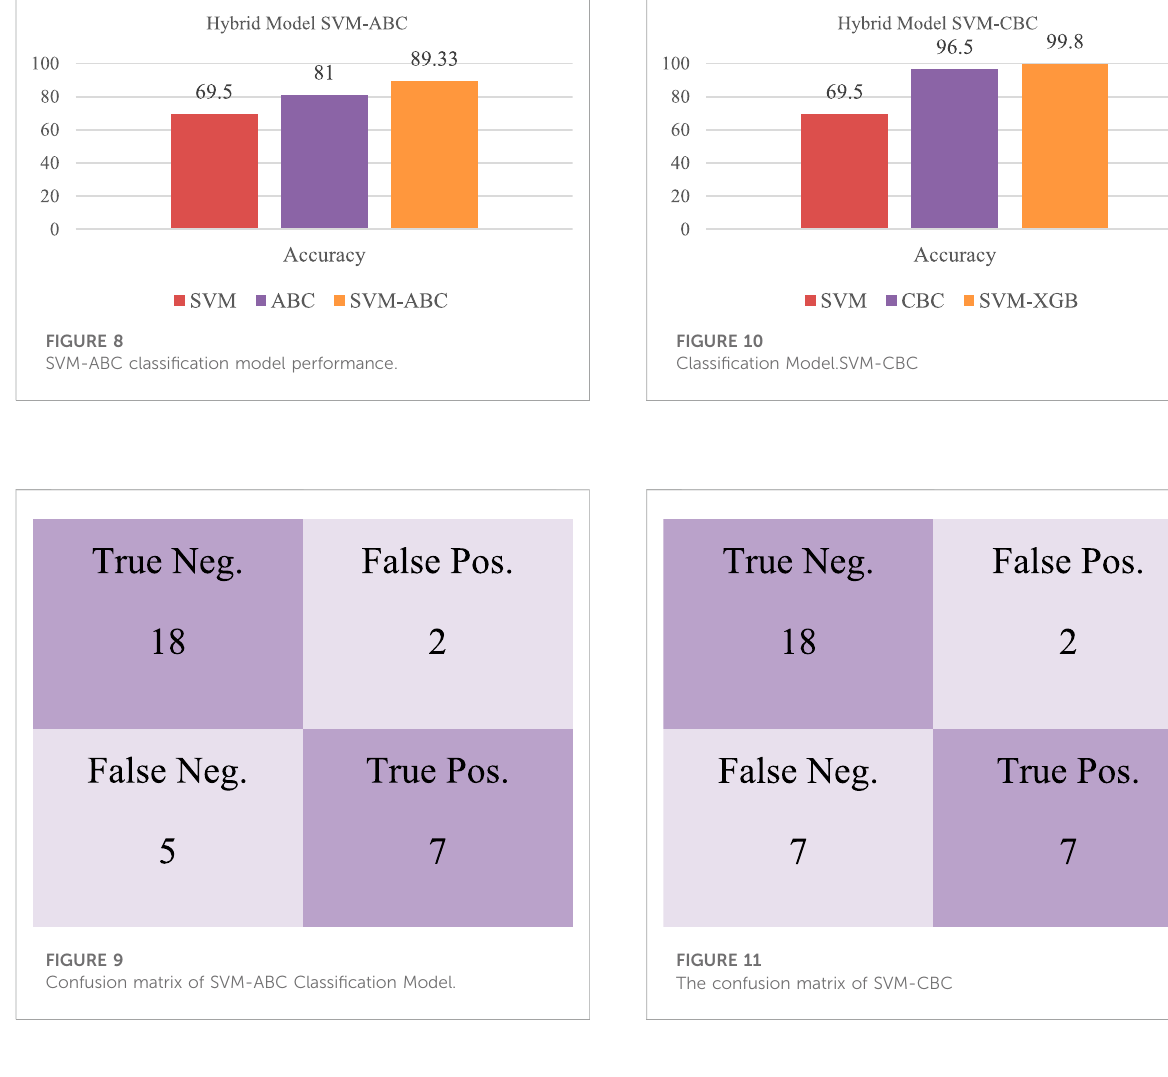
FIGURE 9 Confusion matrix of SVM-ABC Classi fi cation Model.